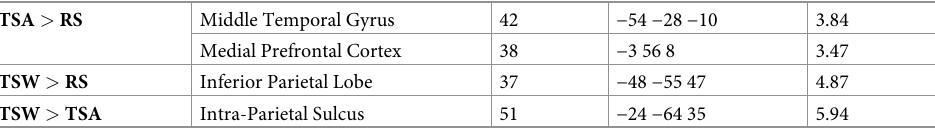
Table 3. Brain areas for each type of transposable nonword condition, relative to the replacement condition.